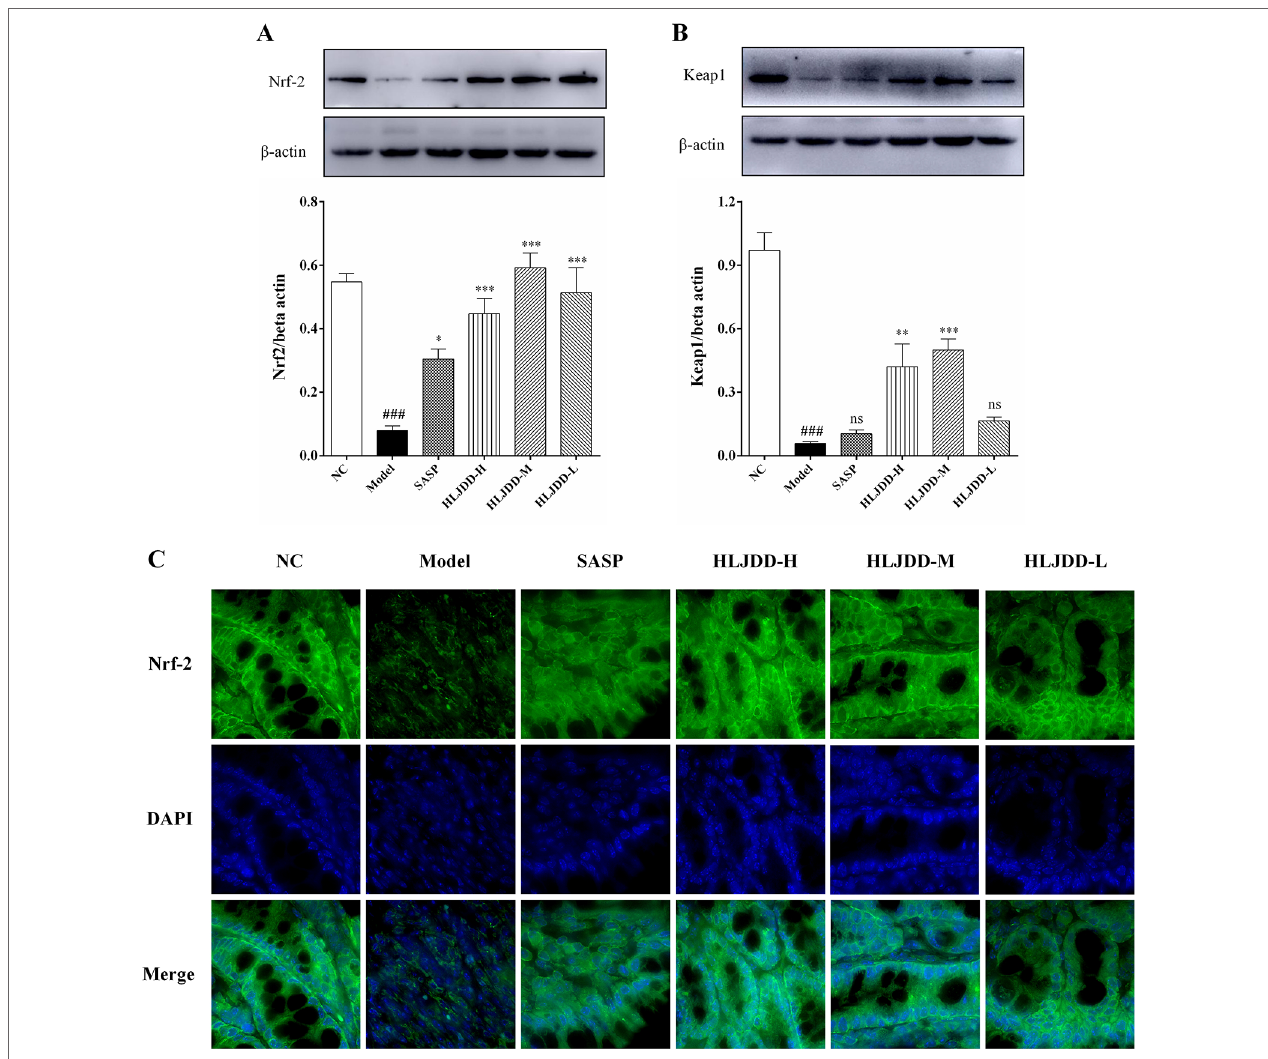
FIgURE 8 | The regulation effect of HLJDD on Nrf2 signaling pathway. HLJDD therapy up-regulates the expression of key proteins Nrf2 (A) and Keap1 (B) involved in the Nrf2 signaling pathway in colon; (C) Immunofluorescence analysis of Nrf2 (green) in colon mucosa (600 × magnification). DAPI was used for nuclear staining (blue). Data are expressed as the mean ± SD, n = 5 per group. ### p < 0.001 vs. NC group; * p < 0.05, ** p < 0.01, *** p < 0.001 vs. model group. ns, no significant. (For interpretation of the references to color in this figure legend, the reader is referred to the web version of this